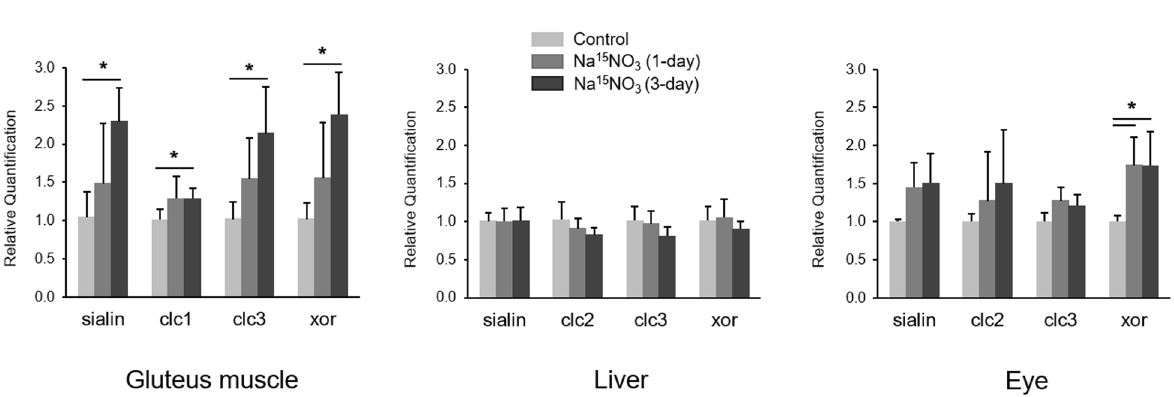
Figure 5. Gene expression analysis. Total RNA was isolated from tissue samples (gluteus skeletal muscle, liver and eye) of control, 1- and 3-day Na 15 NO 3 supplementation group and used for cDNA synthesis. The levels of mRNA were determined by qPCR and relative quantification was calculated by the 2 −ΔΔCt method using gapdh as a reference gene. Data are plotted as average ± standard deviation (n = 3–6, * p <